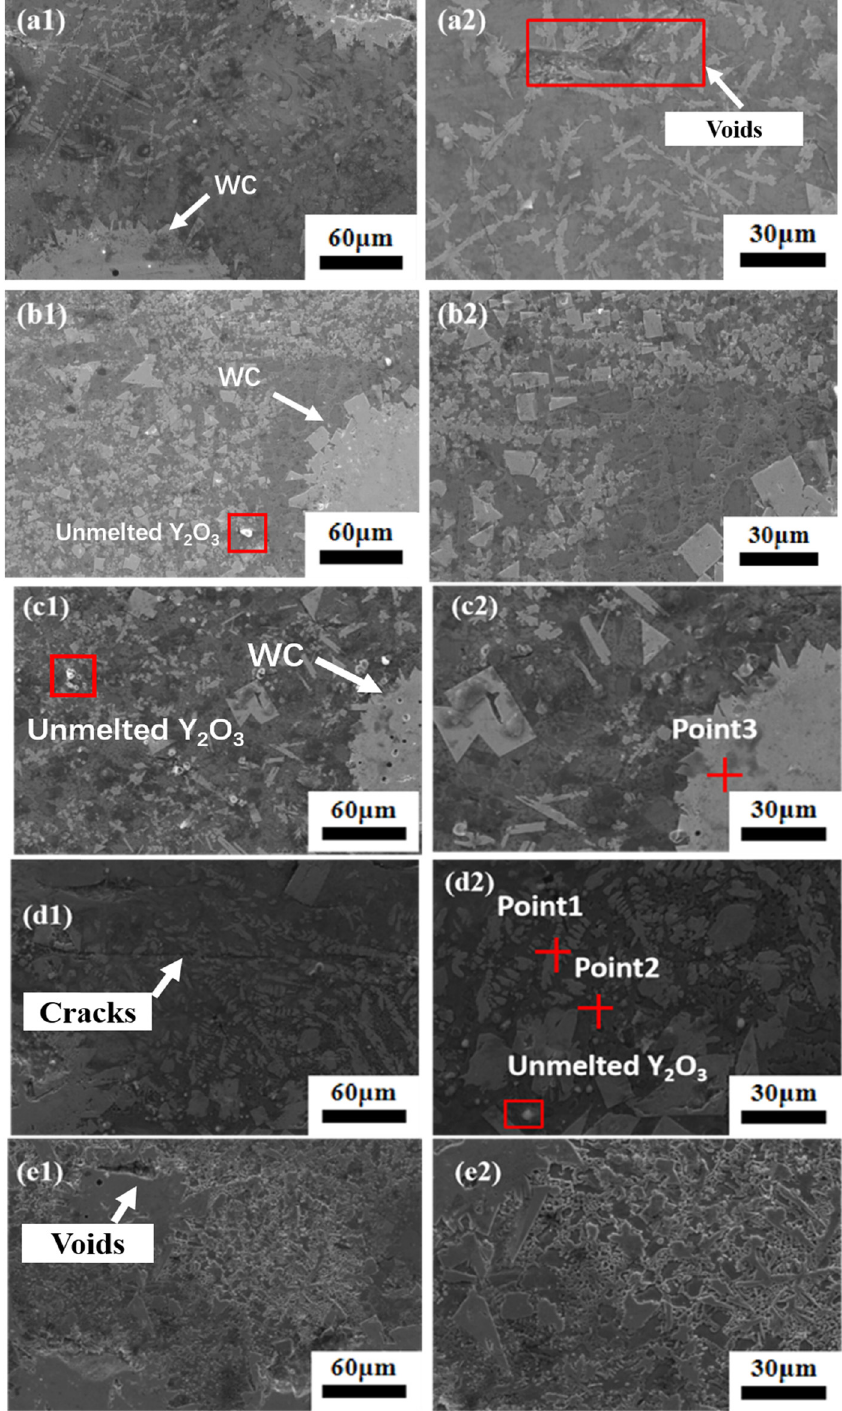
Figure 6: Low and high magni fi ed SEM micrographs of the coatings: ( a1 – a2 ) S1, ( b1 – b2 ) S2, ( c1 – c2 ) S3, ( d1 – d2 ) S4, and ( e1 – e2 )